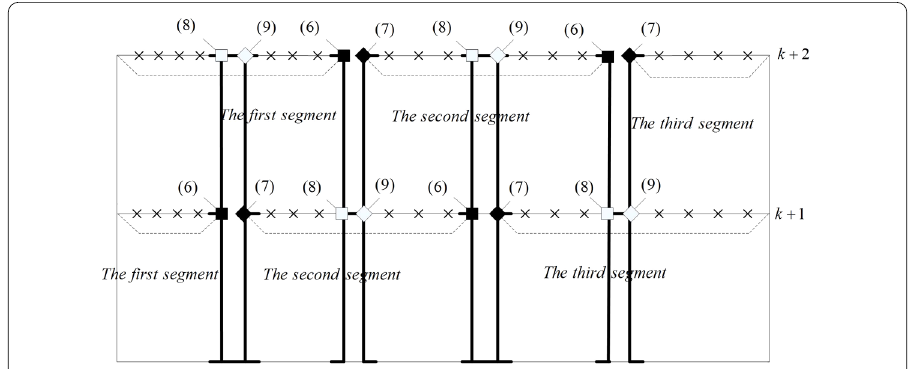
Figure 1 Point diagram of the ASC-N